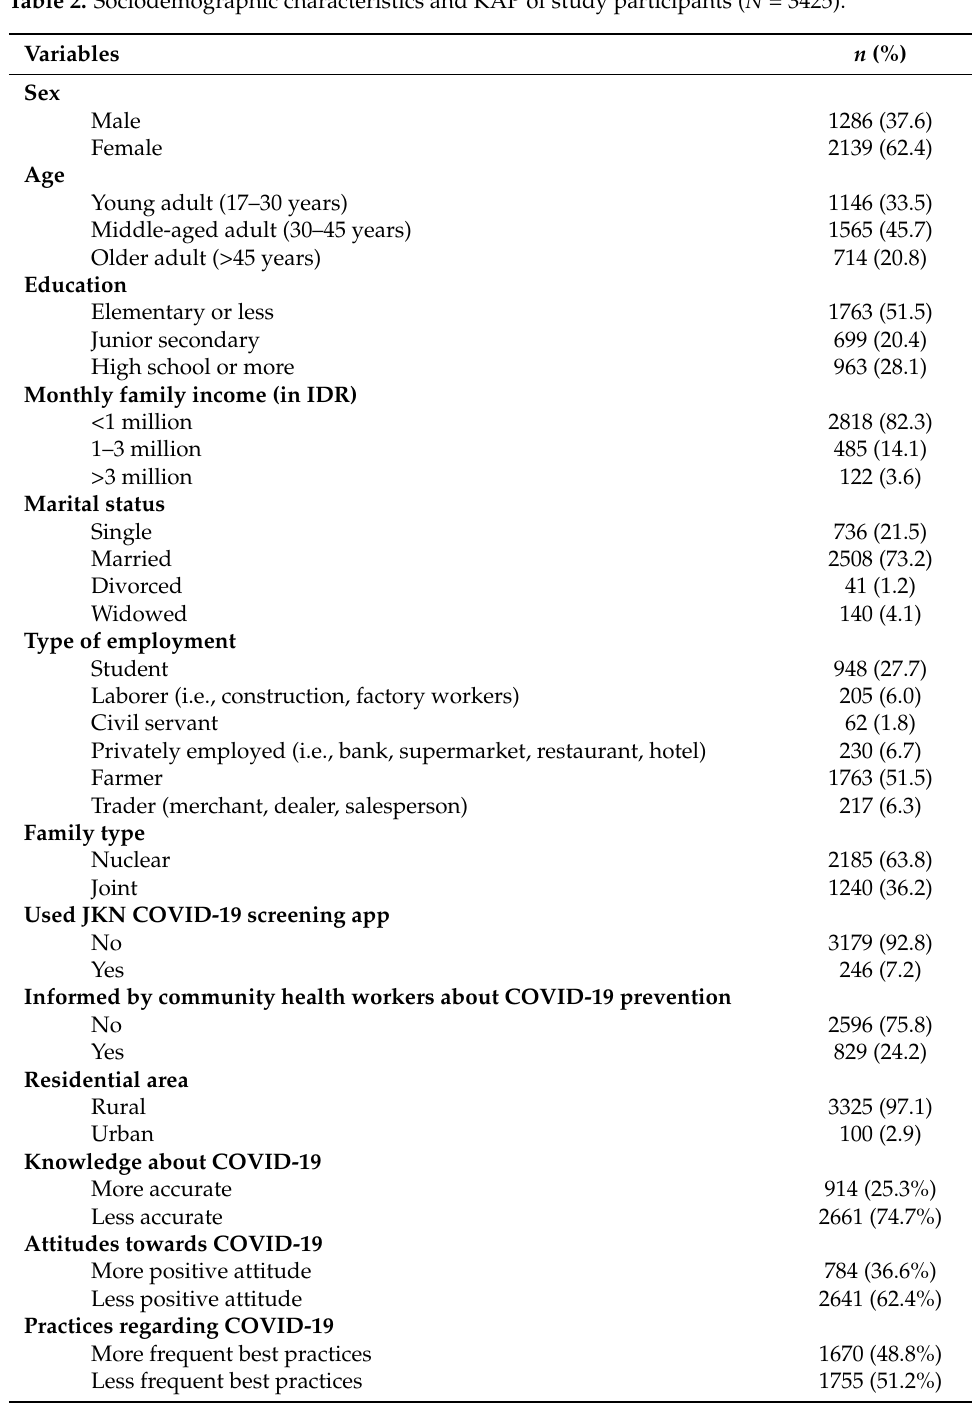
Table 2. Sociodemographic characteristics and KAP of study participants ( N =